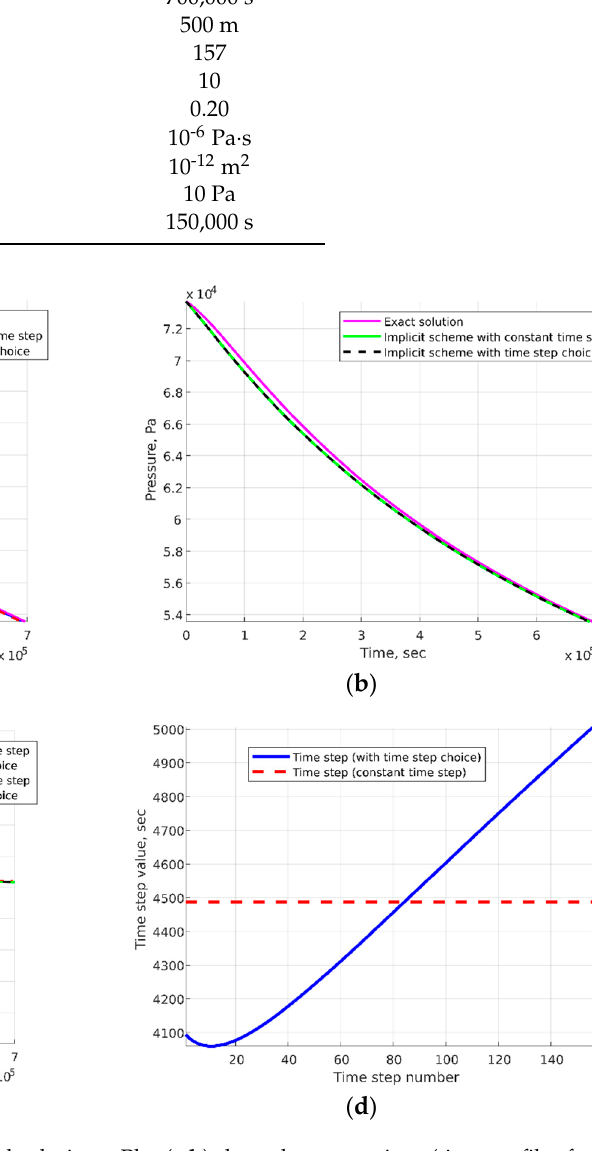
Figure 1. Comparisons between numerical solutions: Plot ( a , b ) show the comparison (time profiles for x = L /2) between the exact solution and numerical solutions for (21) and (22) with the time step choice (23) and with the constant time step; plot ( c ) shows relative errors for numerical solutions of (21) and (22); plot ( d ) represents the comparison between time steps. Table 2. Parameters for numerical calculations.